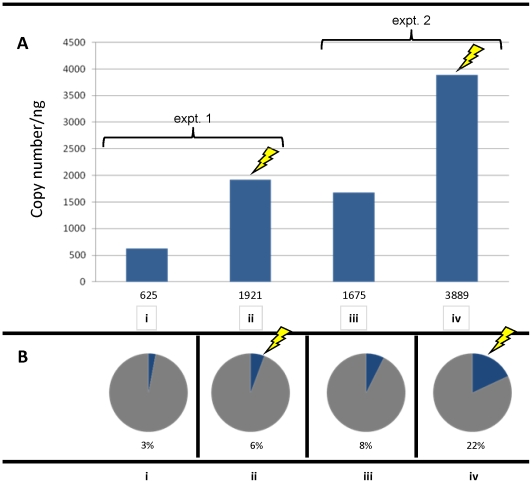
Copy numbers of luciferase transgenes ascertained by quantitative PCR.Panel A: Absolute copy number of the firefly luciferase (FLuc) transgene per ng of genomic DNAs from miracidia hatched from virion-exposed eggs - experiment (expt.) number 1 (i, soaking; ii, electroporation), experiment number 2 (iii, soaking; iv, electroporation). The absolute copy numbers are indicated below the bars. Panel B: Relative FLuc transgene copy number in comparison to the control SmCathD (cathepsin D) single copy gene; the percentages represent the copy number of FLuc for every 100 copies of the cathepsin D gene. Transduced eggs from experiment no. 1 (i, soaking; ii, electroporation) and from experiment no. 2 (iii, soaking; iv, electroporation). The lightning flashes indicate treatment with electroporation.